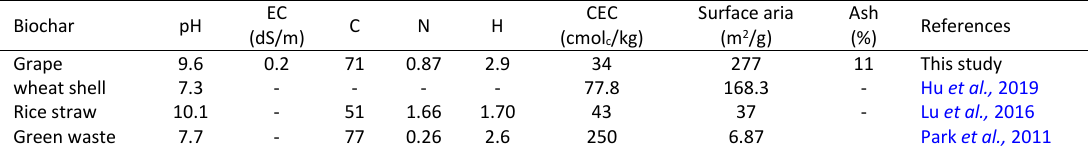
Table 4: Some properties of Gr-biochar